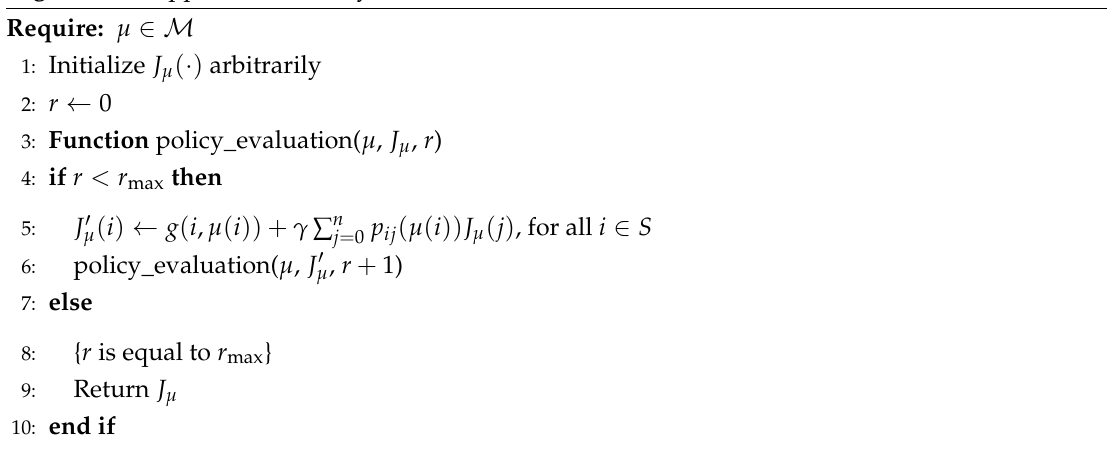
Algorithm 1 Approximate Policy Evaluation